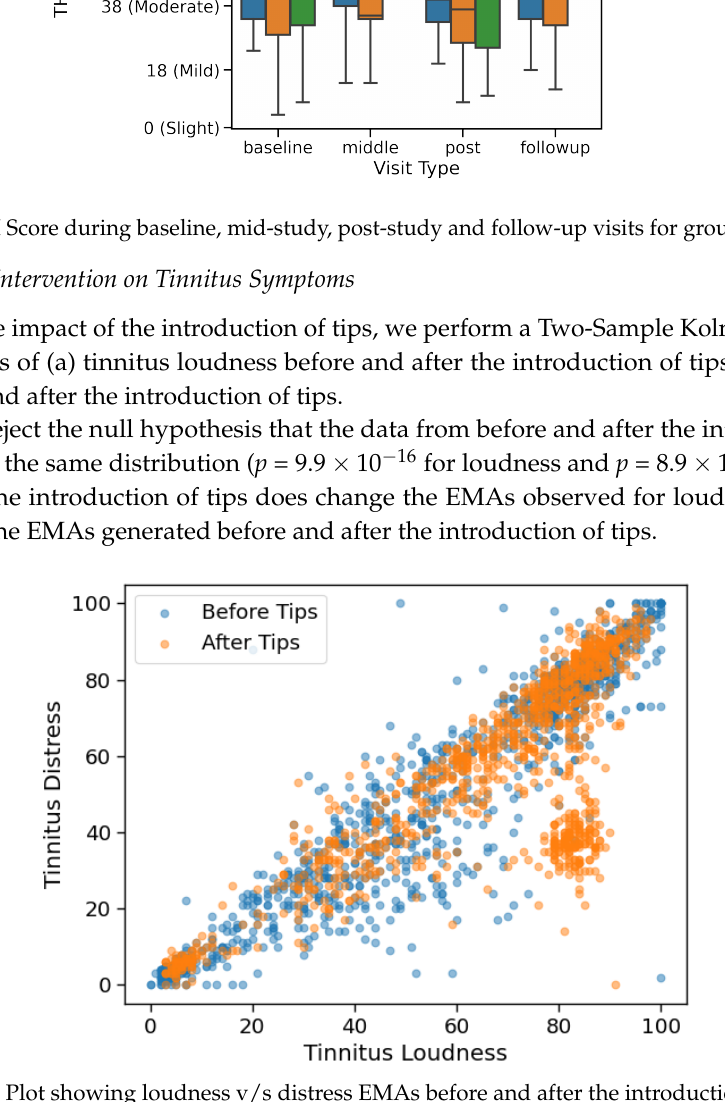
Figure 9. Plot showing loudness v/s distress EMAs before and after the introduction of